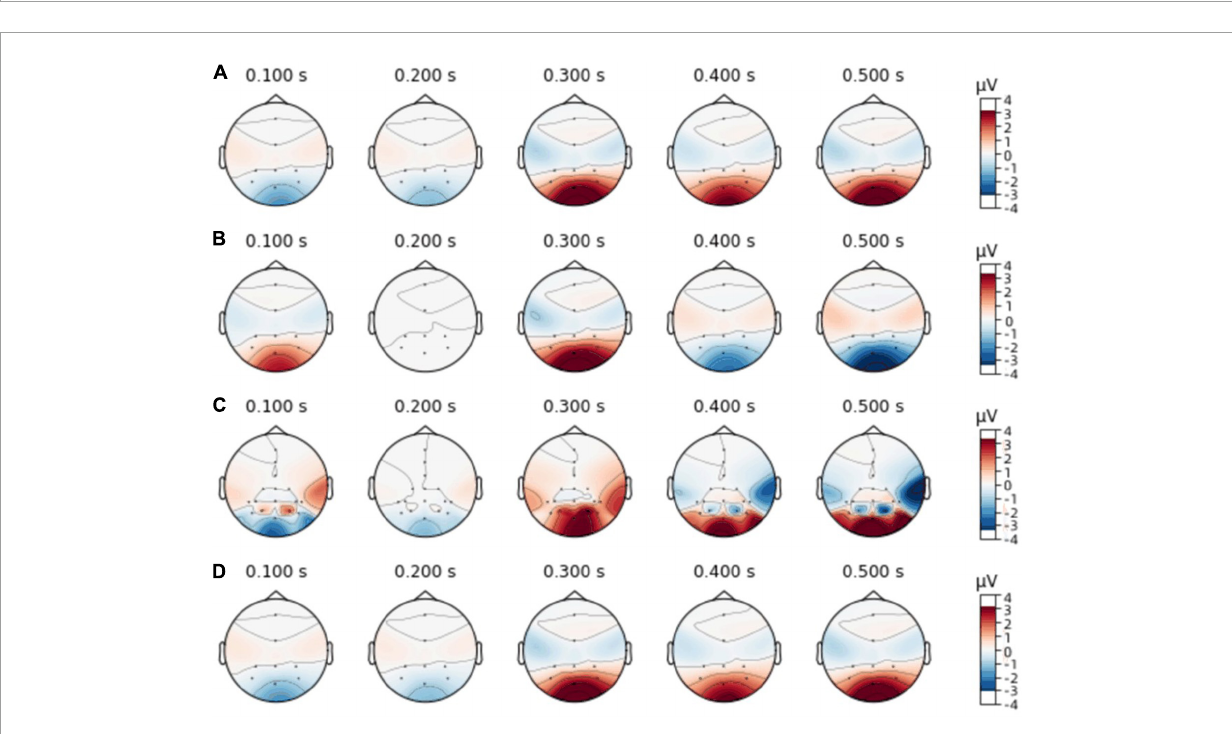
FIGURE5 Electroencephalographic topography. (A,B) Single-person model. (C) Centralized parallel data fusion. (D) Centralized serial data fusion.